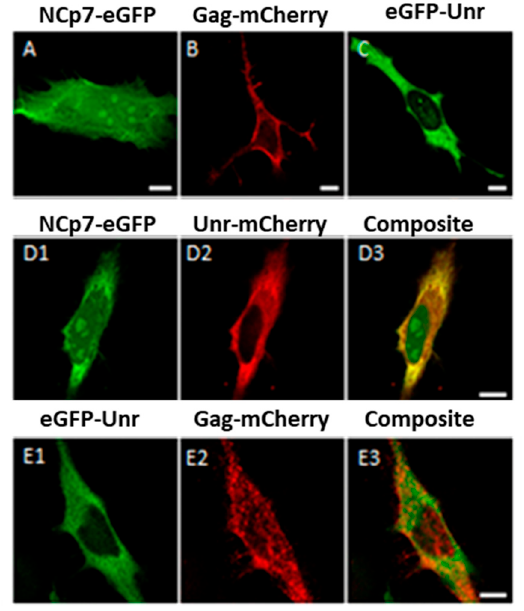
Figure 5. Colocalization of NCp7 and Gag with Unr in HeLa cells. ( A – C ) HeLa cells were transfected with a single plasmid coding for NCp7-eGFP ( A ), Gag-mCherry ( B ), eGFP-Unr ( C ) 24 h before being fixed with paraformaldehyde and imaged by confocal microscopy. ( D , E ) HeLa cells were doubly transfected with constructs overexpressing NCp7-eGFP and Unr-mCherry ( D1 , D2 ) or eGFP-Unr and Gag-mCherry ( E1 , E2 ). ( D3 , E3 ) show the composite images of ( D1 , D2 ) and ( E1 , E2 ), respectively. The bar scale represents 10 μ m.